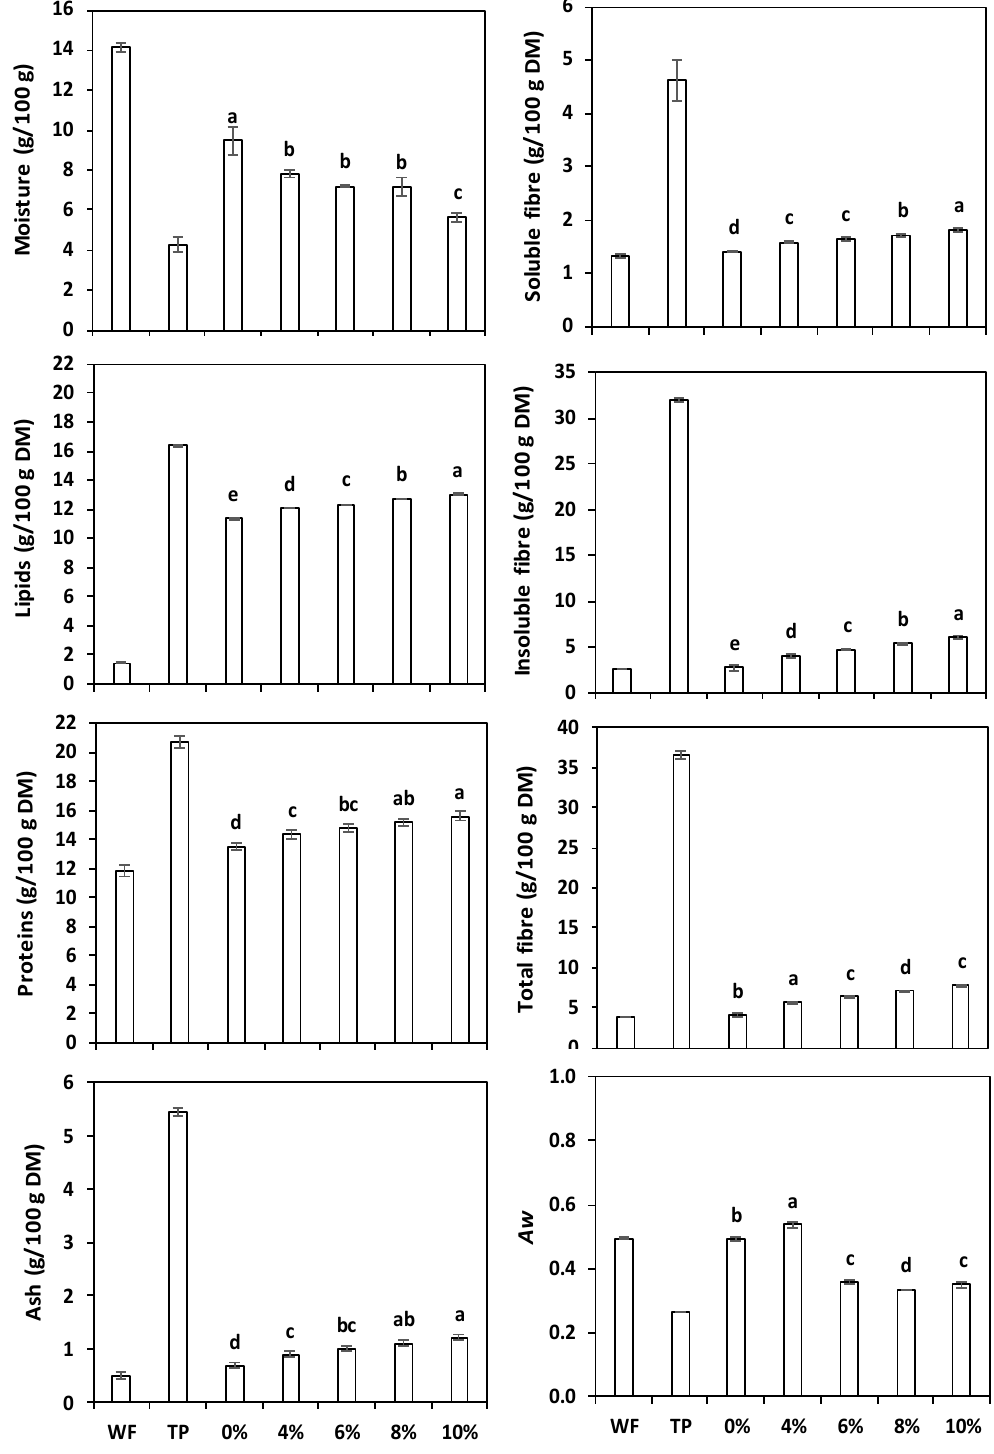
Figure 2. Moisture, composition, and water activity (Aw) of bread wheat flour (WF), tomato pomace (TP), and crackers prepared with increasing TP percentage. The error bars represent the standard deviation; different letters indicate significant differences ( p < 0.05) among cream crackers.